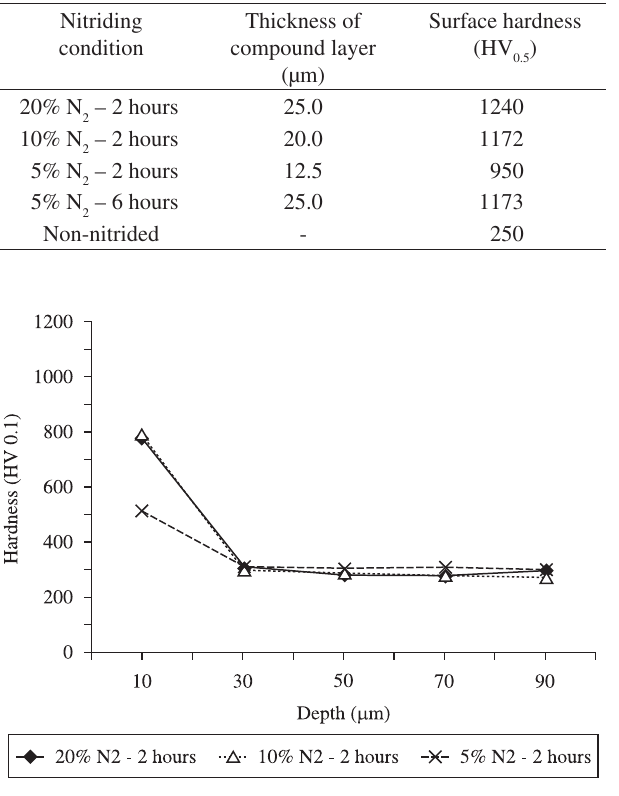
Figure 3. Hardness profiles of processed samples as a function of the gas mixture.